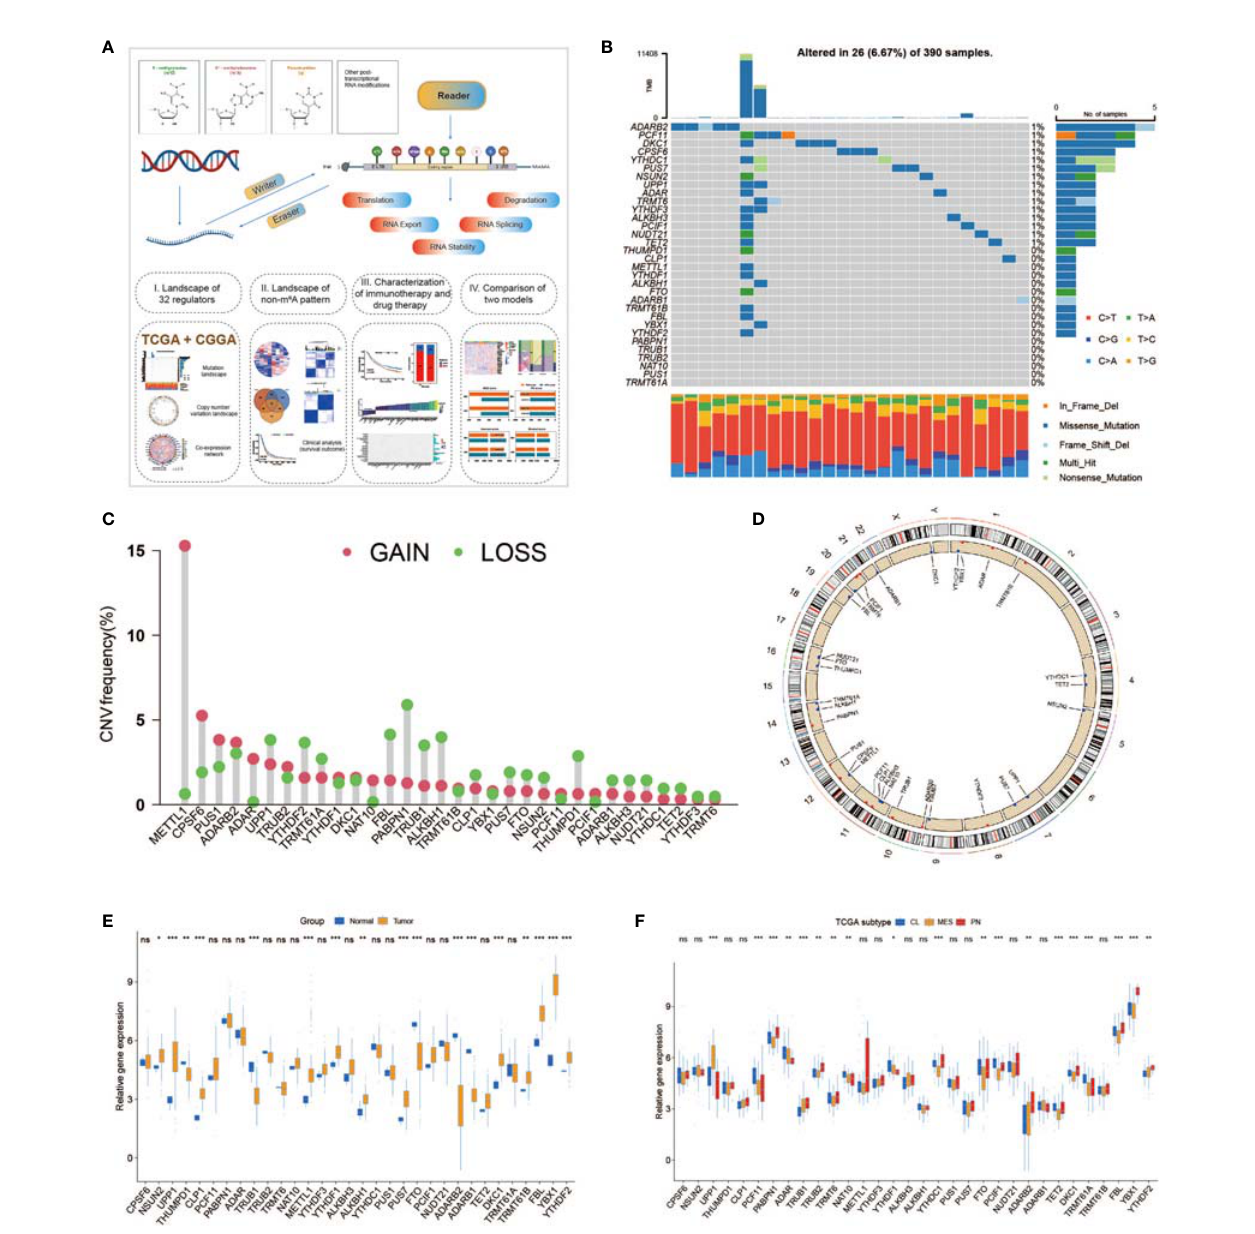
FIGURE 1 | Expression and mutational data landscape of 32 non-m 6 A RNA-modi fi ed regulators in glioblastoma (GBM). (A) Landscape of this study work fl ow. (B) Mutation frequency of 32 non-m 6 A RNA modi fi cation genes in 390 GBMs from The Cancer Genome Atlas (TCGA) database. (C) CNV variation frequency of non- m 6 A RNA modi fi cation genes in TCGA-GBM. (D) The location of non-m 6 A RNA modi fi cation genes on 23 chromosomes in TCGA-GBM. (E) Expression of 32 non- m 6 A RNA modi fi cation genes between normal and GBM patients. (F) Expression of 32 non-m 6 A RNA modi fi cation genes in different TCGA GBM subtypes. * means P<0.05; ** means P<0.01; *** means P<0.001; ns means